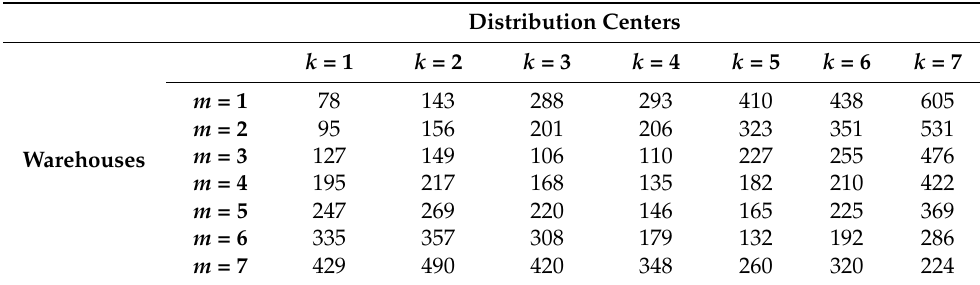
Table A2. Distances between warehouses ( m ) and distribution centers ( k ) in km.